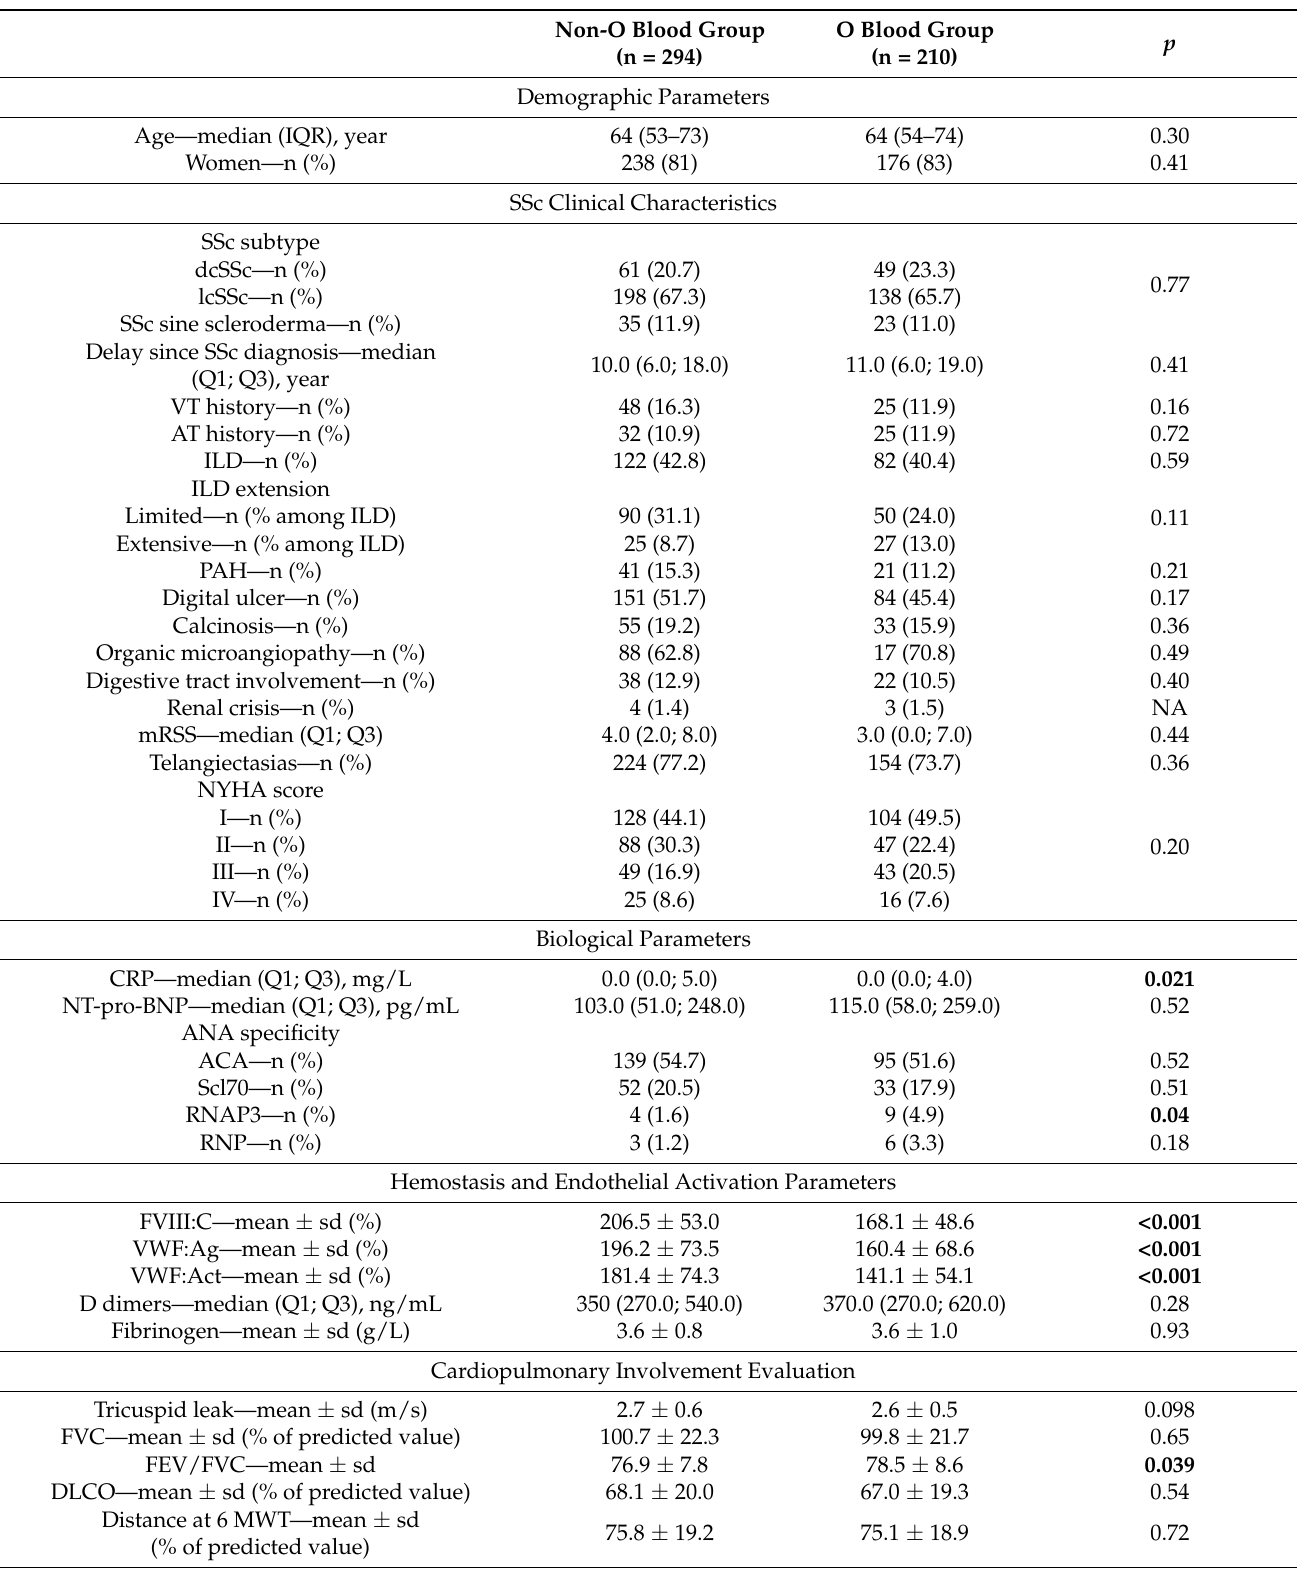
Table 3. Associations between ABO blood groups and SSc